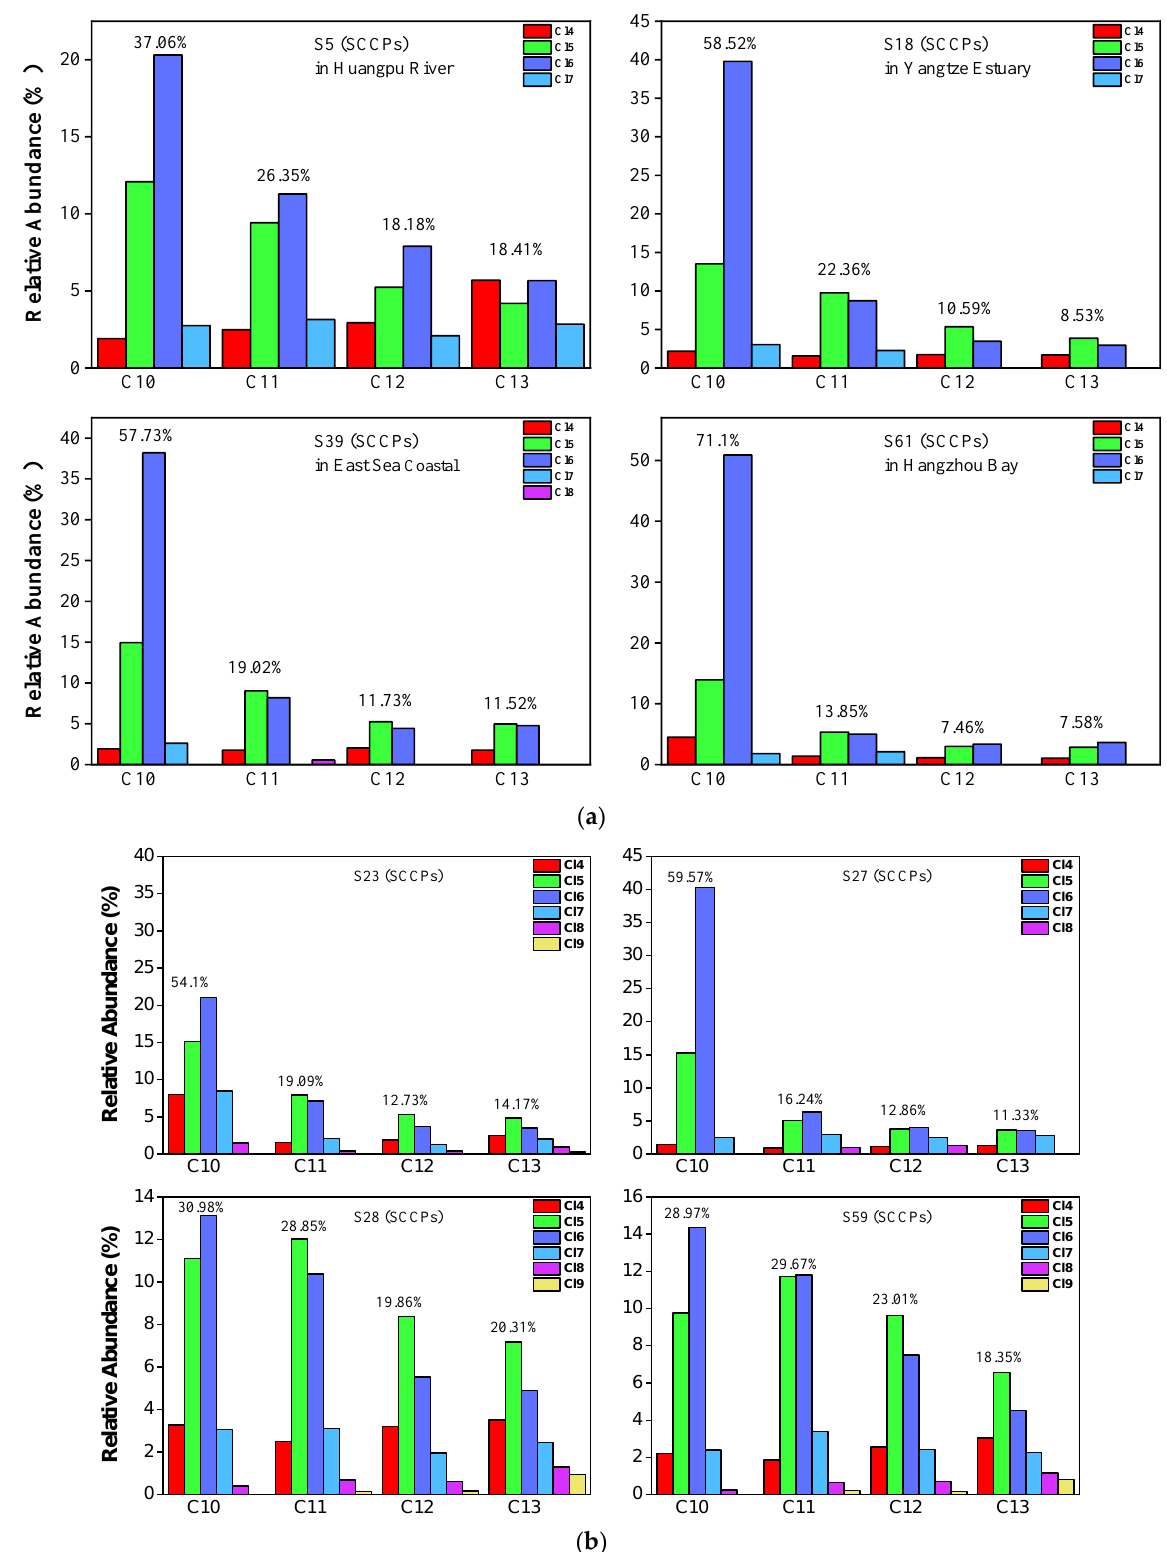
Figure 4. ( a ) Representative congener group abundance profiles of SCCPs in surficial sediments collected from the Huangpu River, Yangtze Estuary, East Sea Coastal, and Hangzhou Bay. ( b ) Representative congener group abundance profiles of SCCPs in surficial sediments from the dredging sediment discarding area.